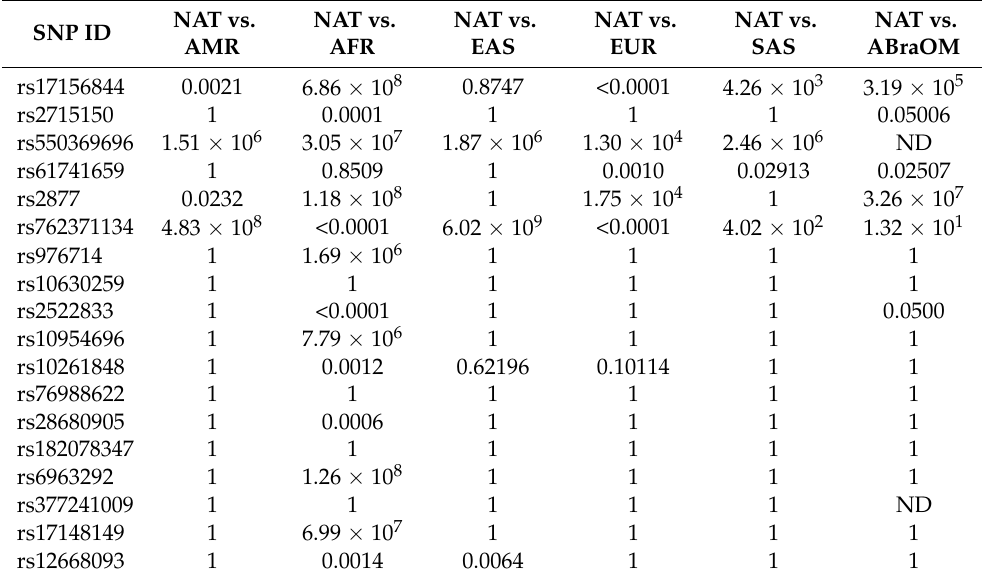
rs377241009 1 1 ND